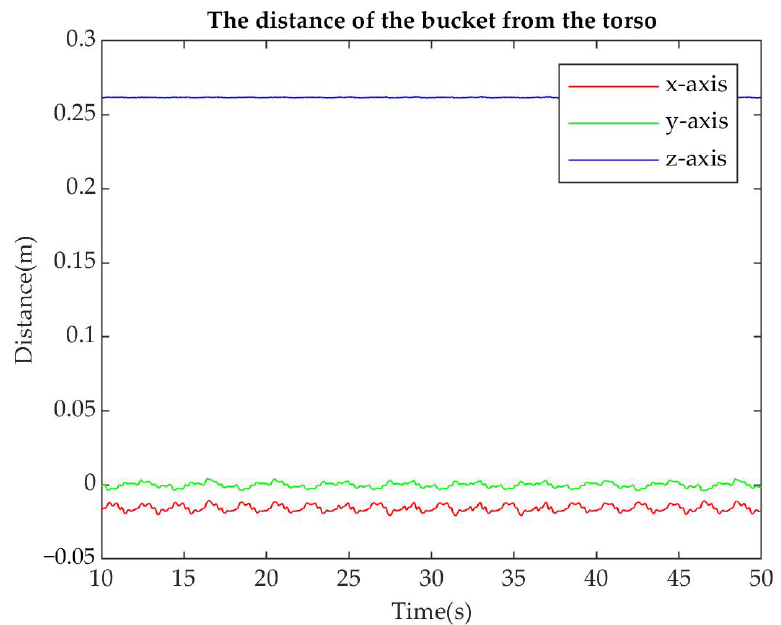
Figure 26. Relative movement of the bucket and torso. In the case of the bucket being not fixed, only a slight slippage occurs above the robot.